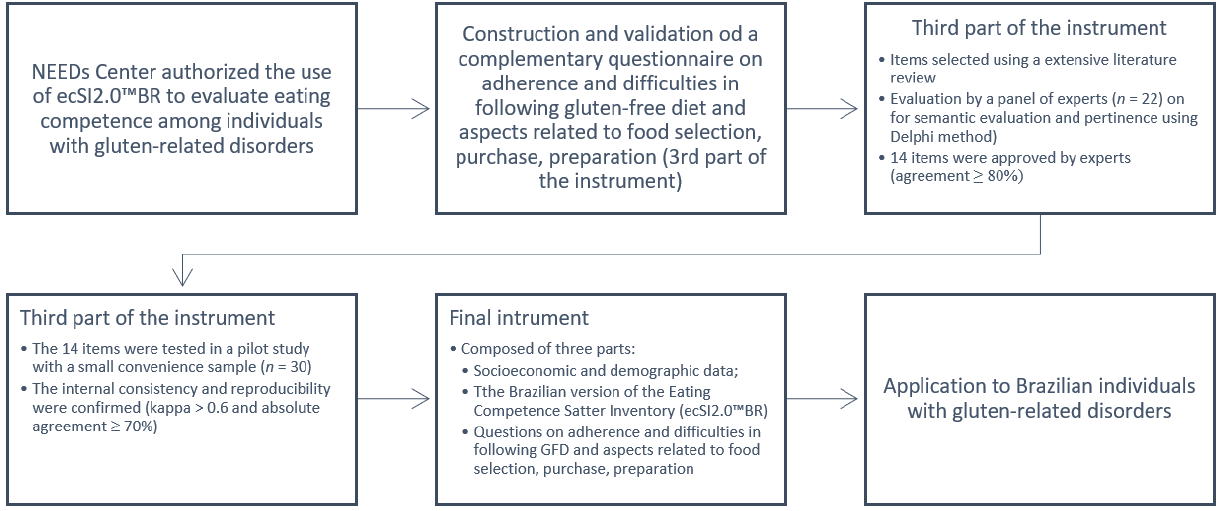
Figure 1. Steps followed until the final instrument